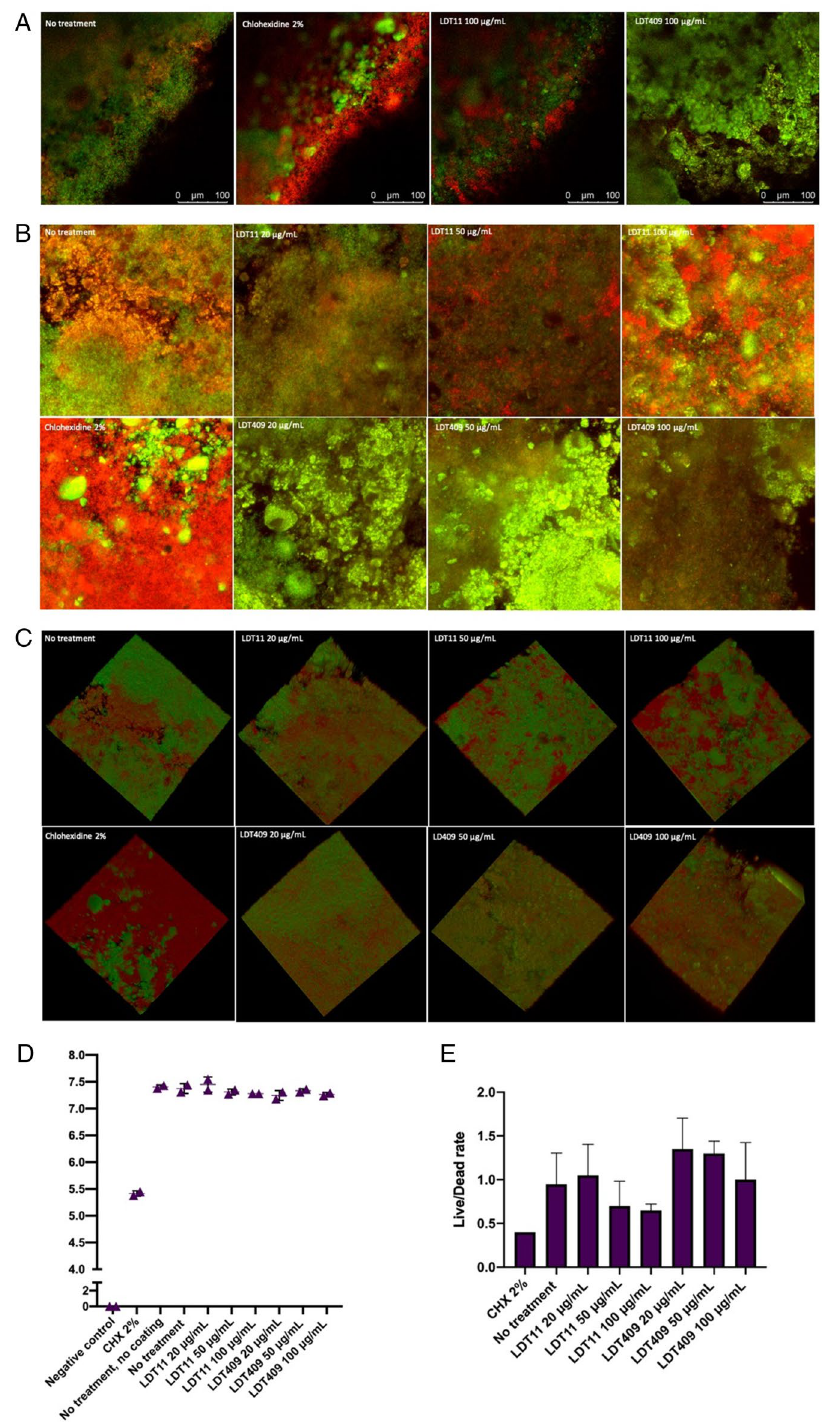
Figure 3. Mature biofilms after treatment with CNSL-derivatives LDT11 (anacardic acid-derivative) and LDT409 (cardanol-derivative). Live/Dead Confocal images in ( A ) 2D biofilms (any point within the biofilm); ( B ) 2D maximum projection, combining all 3D layers; ( C ) 3D biofilm images. ( A–C ) generated using Leica Application Suit X software, v. 3.5.7.23225 (LAS X, https:// www. leica- micro syste ms. com/ produ cts/ micro scope- softw are/p/ leica- las-x- ls/). ( D ) Averages and standard deviation of CFU in log + 1; ( E ) Live/Dead ratio calculated by the area of red and green within the maximum projection images. Kruskal–Wallis results >